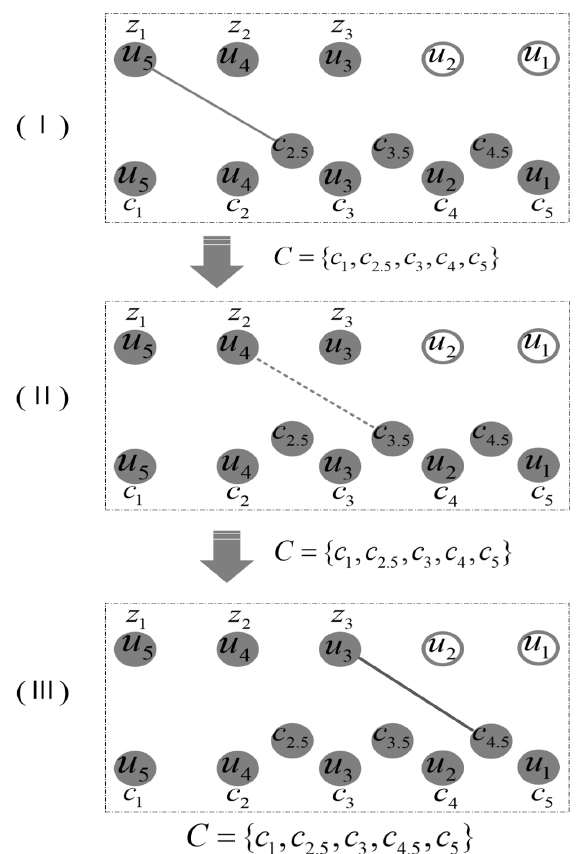
Figure 5. Second pruning of the path, ( I ) shows the point z 1 and the point c 2.5 are connected successfully; ( II ) shows the point z 2 and the point c 3.5 fail to connect; ( III ) shows the point z 3 and the point c 4.5 are connected